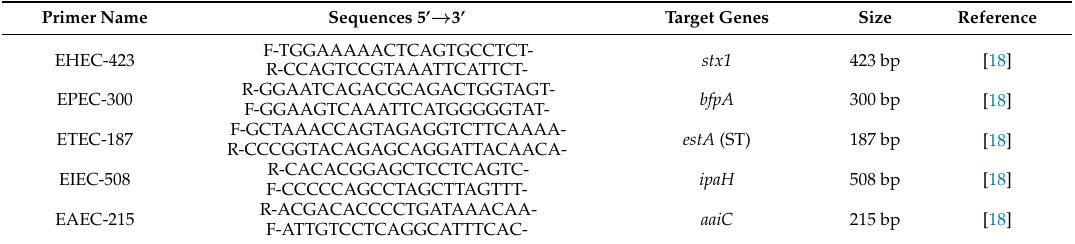
Table 1. Oligonucleotides used in this study for the amplification of several genes representing E. coli